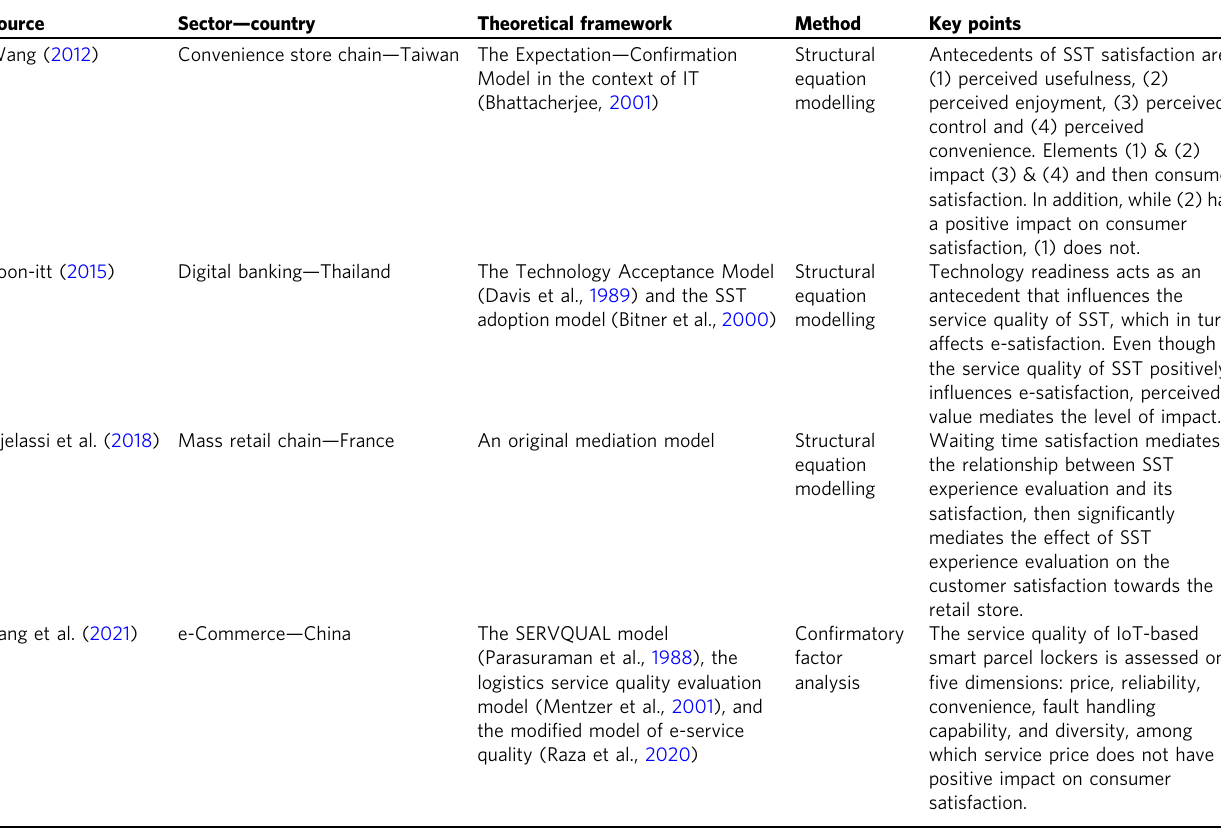
Table 1 Critical studies on customer satisfaction with self-service